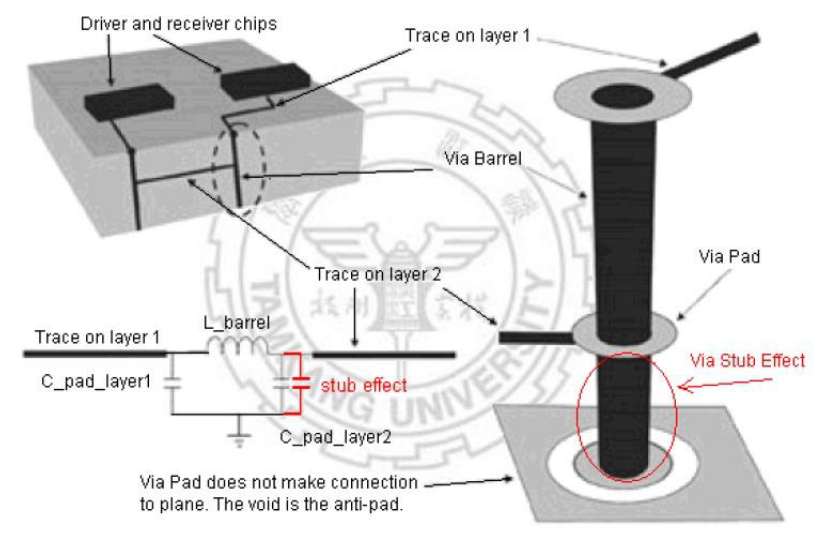
Figure 5. Electromagnetic interference through hole.